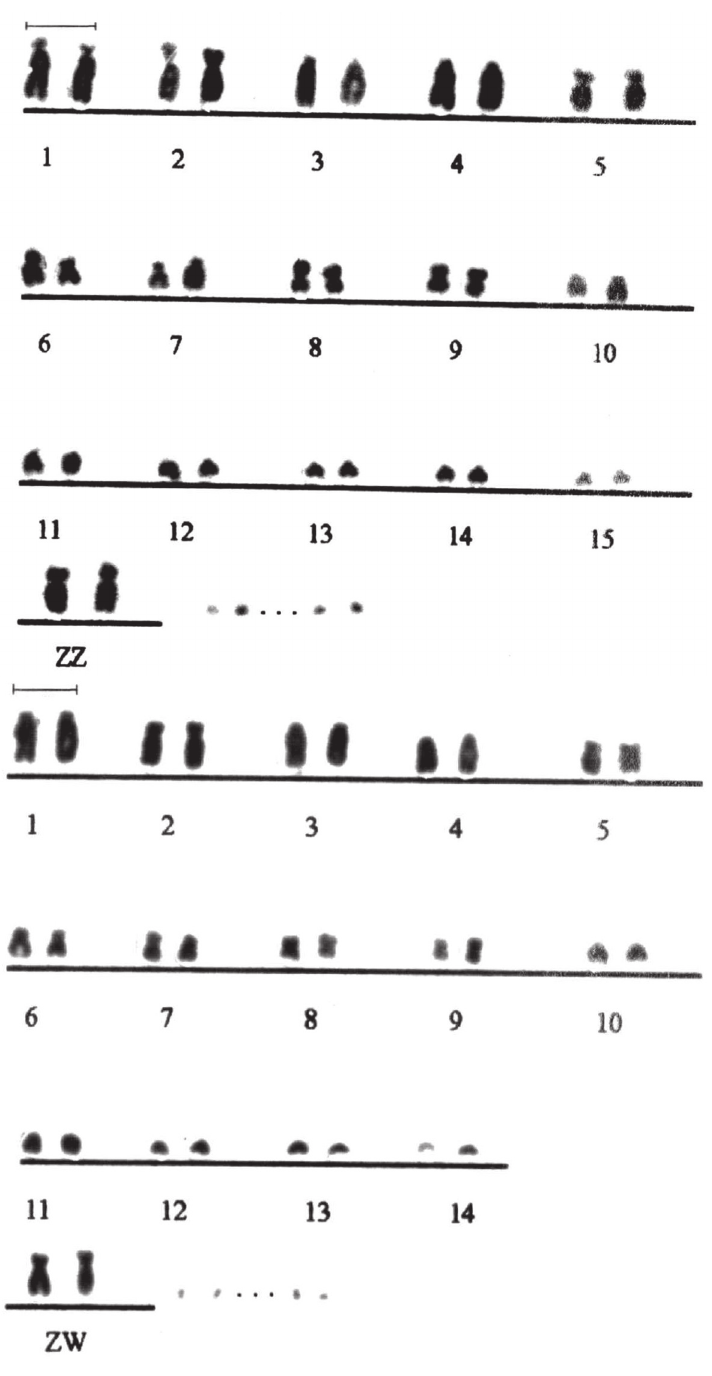
Figure 1. Male and female partial karyograms (without microchromosomes) of Nyctibius griseus (2n=86 ±). The similarity of the sex chromosomes ZZ and ZW is noticeable. Bar = 5